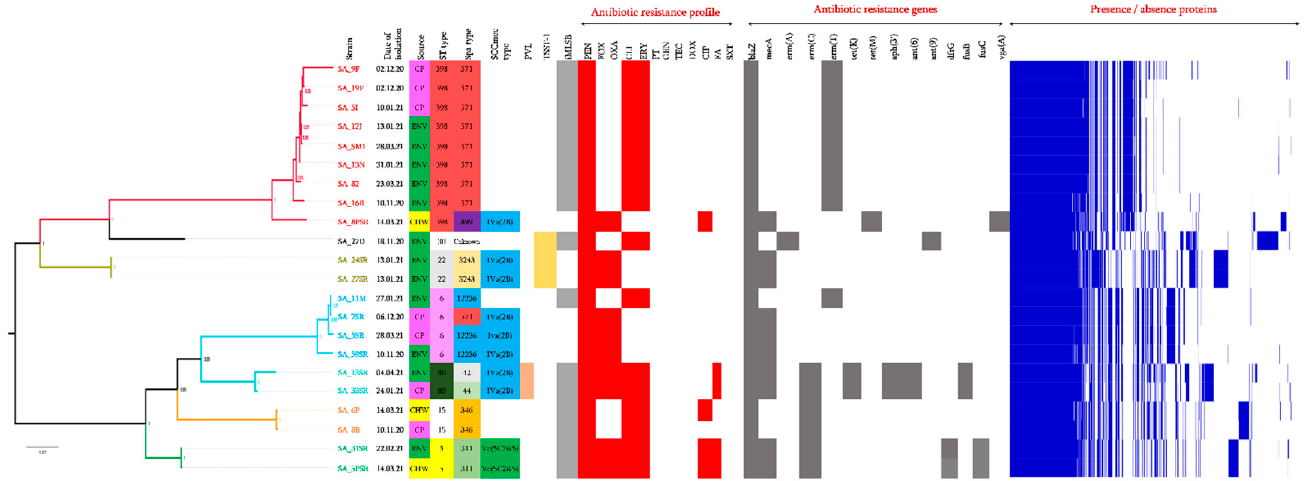
Figure 2. Pangenome analysis of the 22 sequenced S. aureus isolates, their date of isolation, the pres- ence of PVL and TSST, their antibiotic resistance profile, and genetic features. CP: carriage patient, Env: environmental, CHW: carriage health worker, PEN: penicillin, FOX: cefoxitin, OXA: oxacillin, DOX: doxycycline, CLI: clindamycin, CIP: ciprofloxacin, ERY: erythromycin, PT: pristinamycin, FA: fusidic acid, GEN: gentamicin, TEC: teicoplanin, SXT: trimethoprim/sulfamethoxazole.